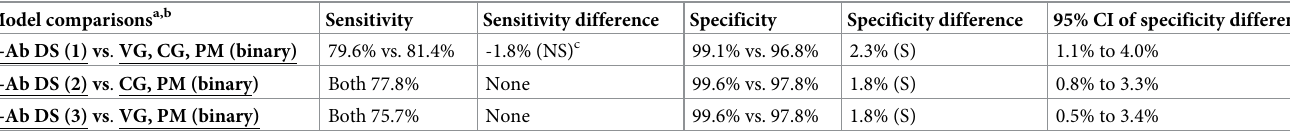
Table 4. Comparative specificity of multi-antibody assays at equivalent sensitivity.